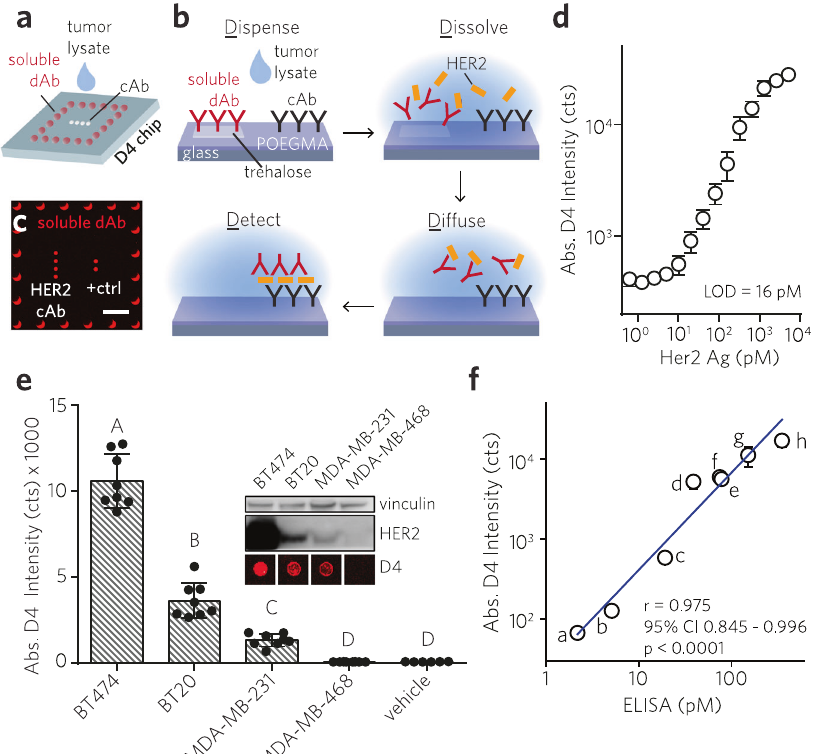
Fig. 2 D4 sandwich immunoassay for quanti fi cation of HER2 expression level and its in vitro assessment. a – c , Schematic and operation of D4 immunoassay. a Spots of immobile cAb and an excess of “ soluble ” fl uorescently labeled dAb are printed directly onto POEGMA-coated glass. b Dispensing sample fl uid onto chip surface leads to dissolution of soluble dAb spots, followed by diffusion-driven mixing and antibody “ sandwich ” formation if HER2 is present. HER2 binding is detected by fl uorescence imaging. c Representative fl uorescence image of D4 assay after exposure to HER2-spiked RIPA buffer. Scale bar, 1 mm. d Representative dose-response curve generated from D4 chips for RIPA buffer spiked with recombinant HER2. Error bars: mean ± s.d. of duplicate assays. e , Assessment of cultured breast cancer cell lines (BT474, BT20, (F(4, 31) = 179.4, p < 0.0001). Bars with different letters indicate different groups (Tukey post hoc test, p ≤ 0.05). f Concordance analysis of 8 different patient-derived tumor cell lines in culture for HER2 expression by D4 assay vs. ELISA performed by clinical lab; specimens indexed “ a